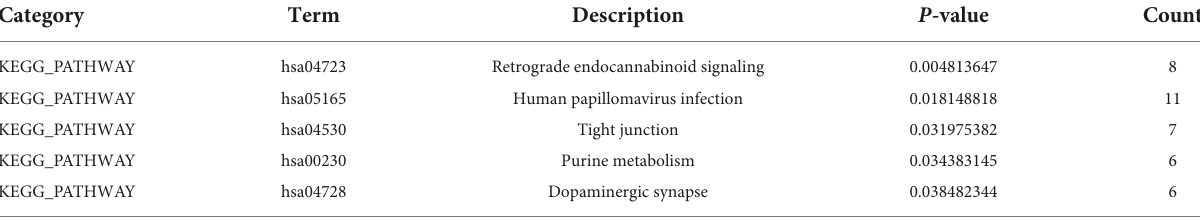
TABLE 2 Significant enrichment of the Kyoto encyclopedia of genes and genomes (KEGG) pathway.